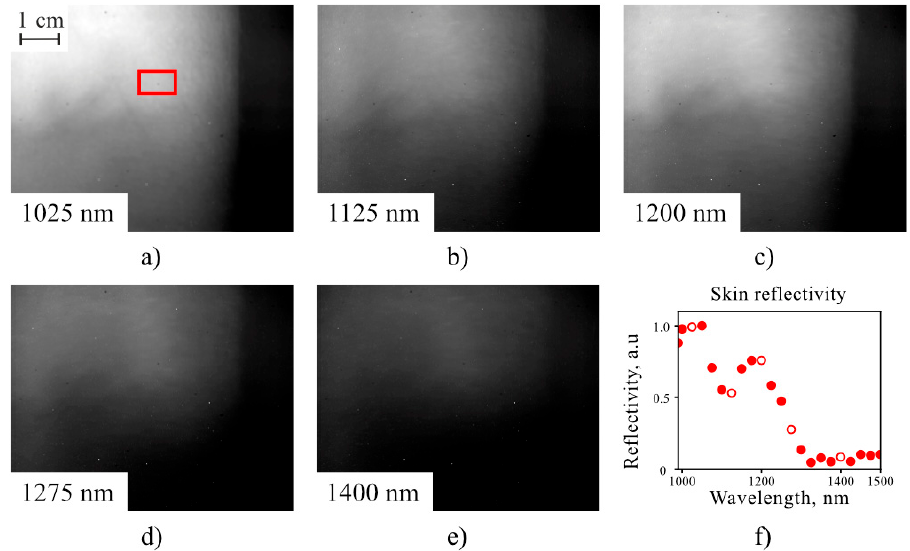
Figure 8. Spectral images ( a – e ) of an elbow pit and the reflectivity spectrum ( f ) of the location marked with red rectangle for the region of interest (ROI). The scale bar is 1 cm. Red circles are experimental data. The presented images ( a – e ) correspond to the key spectral points depicted with white-filled circles.